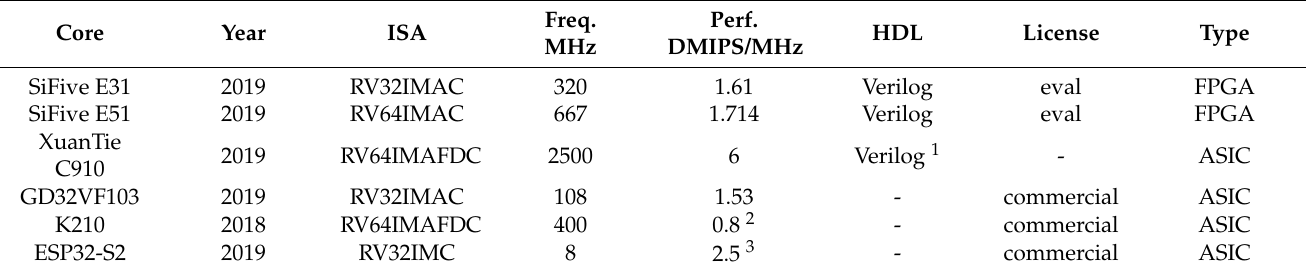
Table 3. RISC-V cores that are commercially